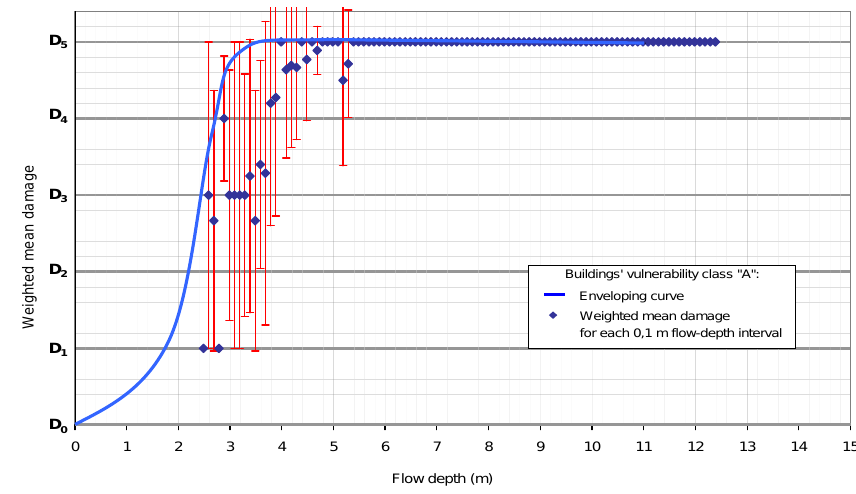
Fig. 7. Enveloping curve for the building vulnerability class “A”. Standard deviation for mean damage level ¯ D i is shown with red bars.